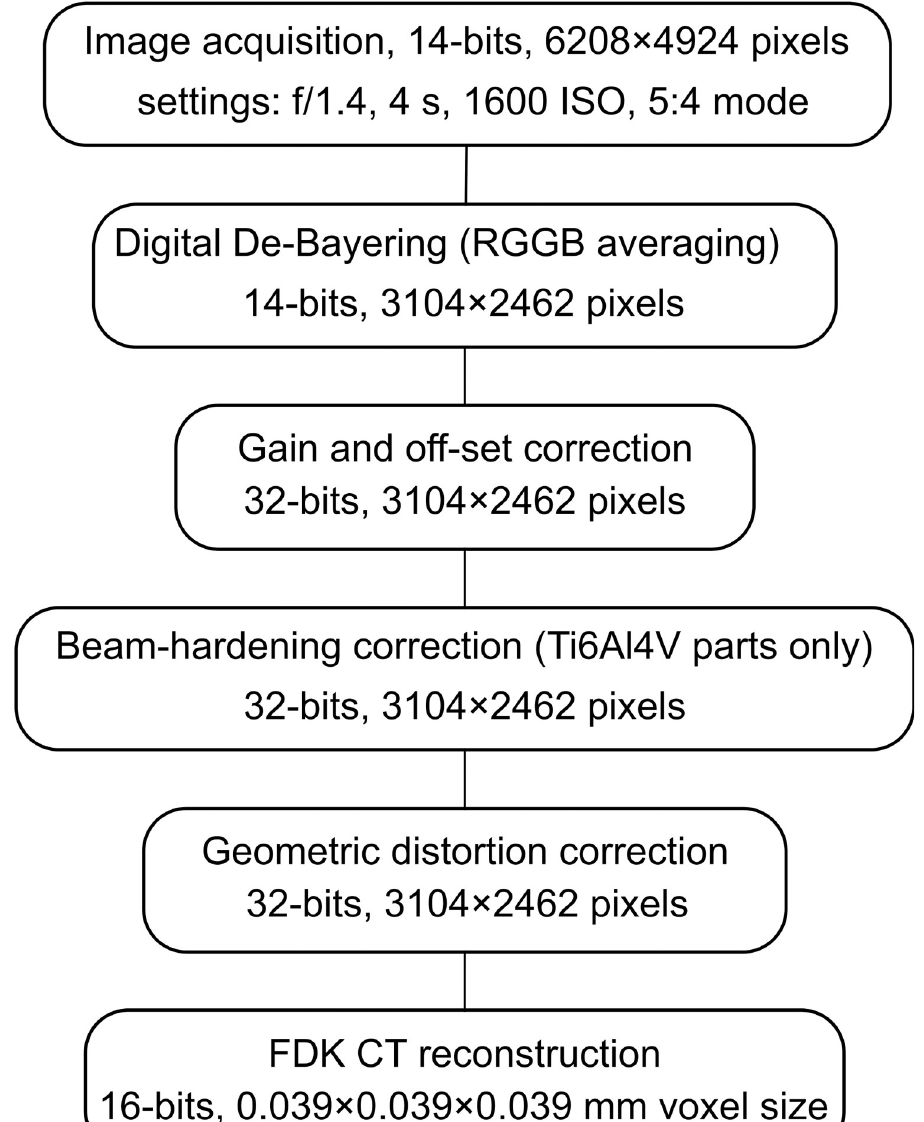
Fig 3. Summary of image processing steps required between projection data acquisition and CT